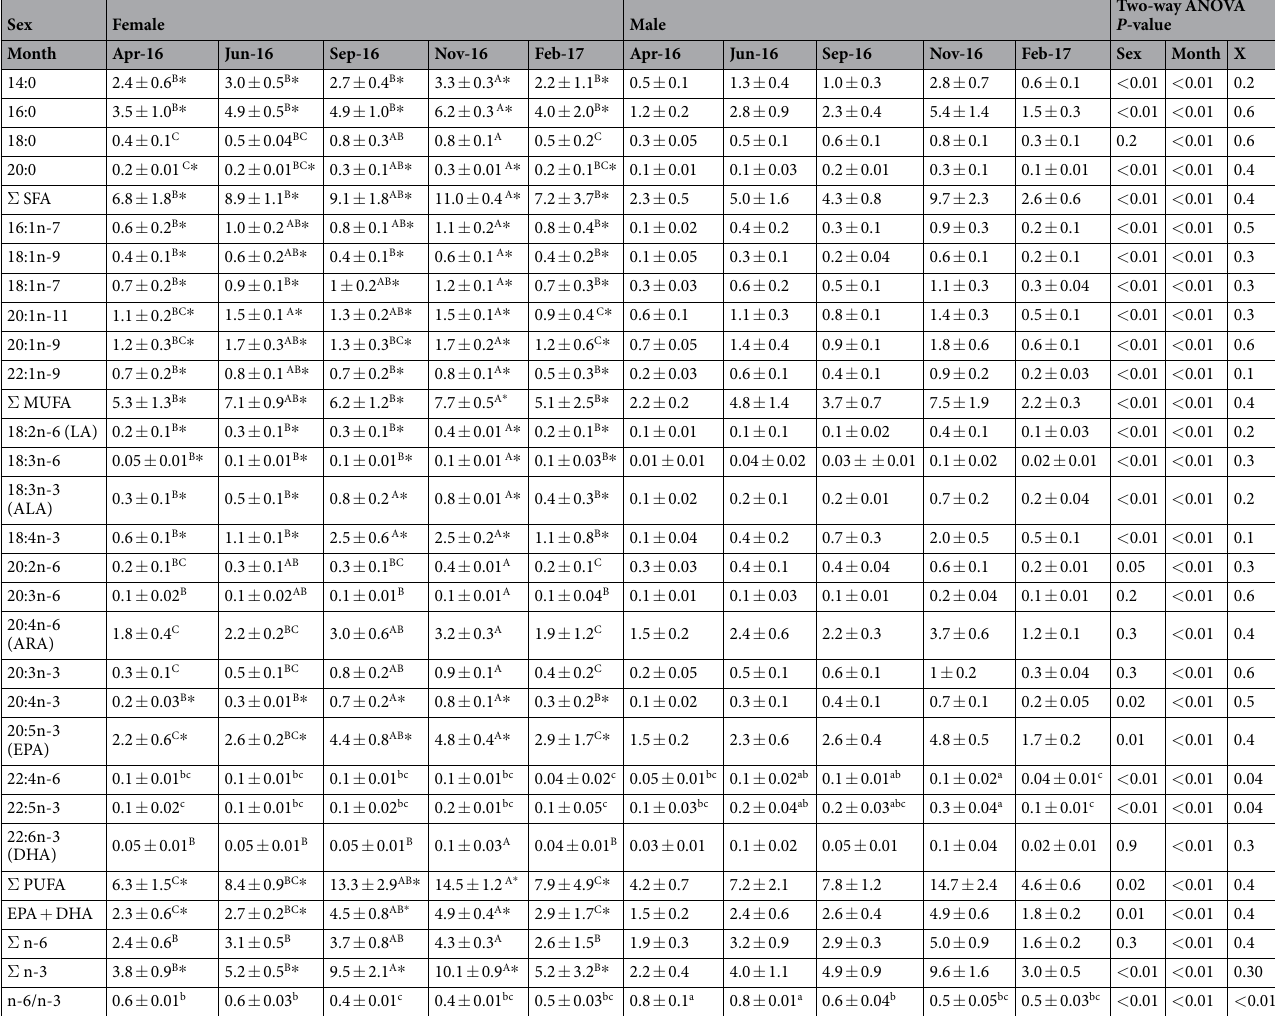
Table 2. Gonad fatty acid composition (mg.g − 1 WW) of P . lividus females and males collected at Praia Norte (Portugal) at five distinct periods. Values are mean ± standard deviation; per month the 18 individuals were pooled by sex: N = 3 pools of female gonads and N = 3 pools of male gonads were established. Within a row, superscripts in capital letters ( ABC ) indicate significant differences between months, asterisk ( * ) indicate differences between sexes and in lowercase letters ( abc ) indicate significant differences between sex X